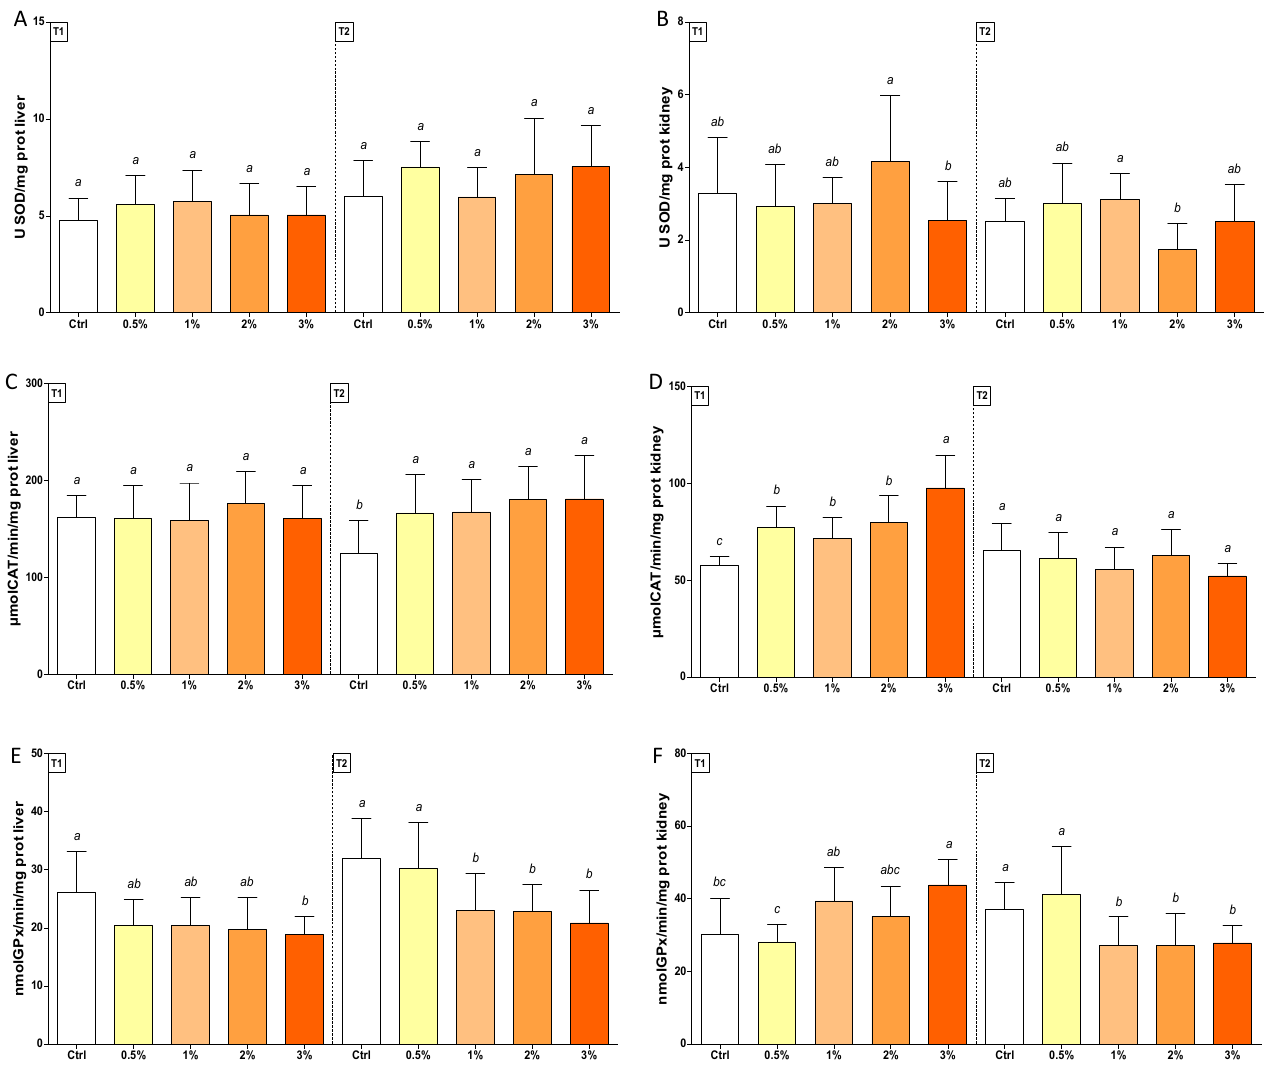
Figure 2. Enzymatic activity of SOD (Panel ( A , B )), CAT (Panel ( C , D )) and GPx (Panel ( E , F )) in livers (on left, Panel ( A , C , E )) and kidneys (on the right, Panel ( B , D , F )) of rainbow trout Oncorhynchus mykiss fed with F1-BEO-supplemented diets (0.5%, 1%, 2%, 3% ( w / w ) supplementation) after 15 (T1) and 30 (T2) days. Different lowercase letters indicate statistically significant differences among experimental groups ( p < 0.05) for each experimental endpoint. GST levels were consistently lower than control (30%) in 1 – 2 – 3% ( w / w )-fed trout in the liver, whereas enzyme activity was enhanced (50%) in fish exposed to 0.5% ( w / w ) basil essential oil diet in T2 (Figure 3, Panel A). In kidneys, enzyme activity was restored in T2, except in trout fed with the 3% ( w / w ) F1-BEO diet (Figure 3, Panel B). GR activity increased (2-fold) in T2 in livers of trout treated with 1 – 2 – 3% ( w / w ) F1-BEO diets, whereas only an early and transient depletion (30%) was observed in kidneys in fish fed with 3% ( w / w ) F1-BEO diet (Figure 3, Panel C and D).